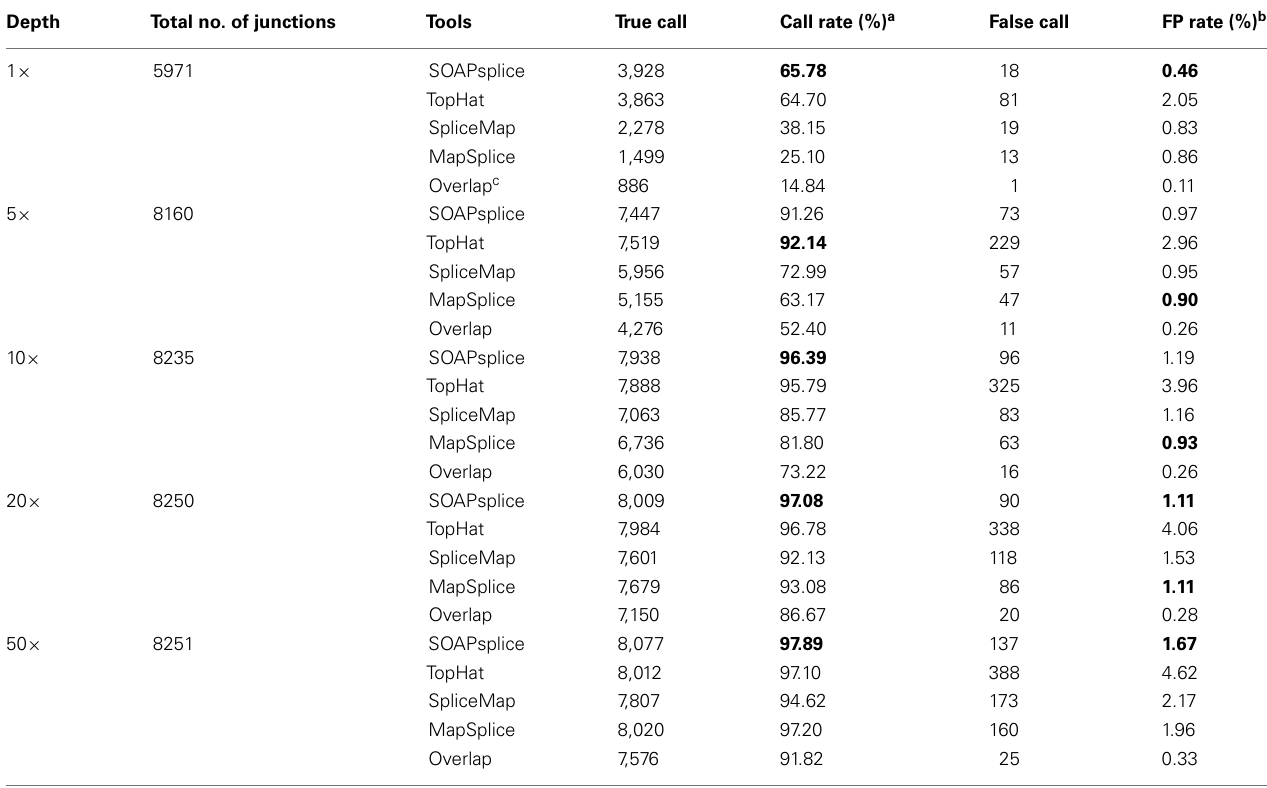
TableA2 | Statistics of the junctions detected on the 150-bp simulated reads. Depth Total no. of